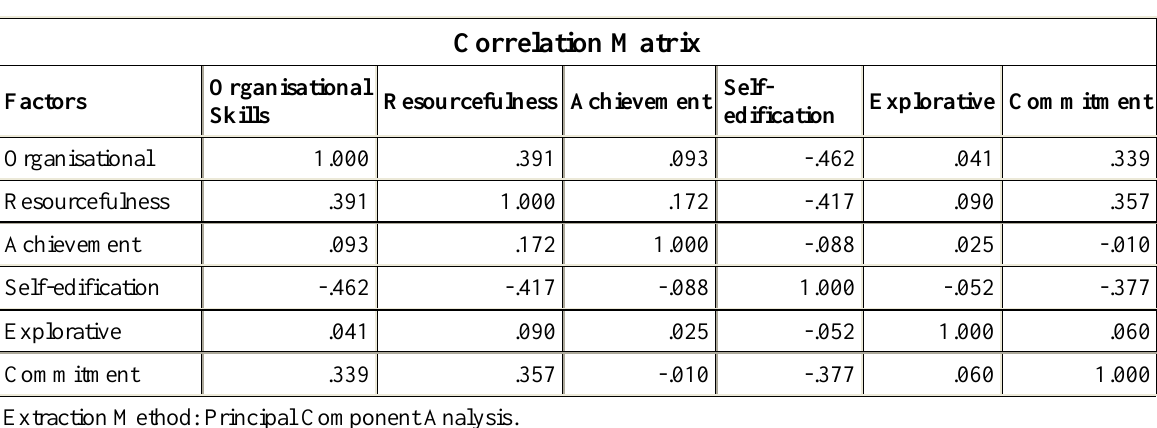
Table 4: Correlation Matrix